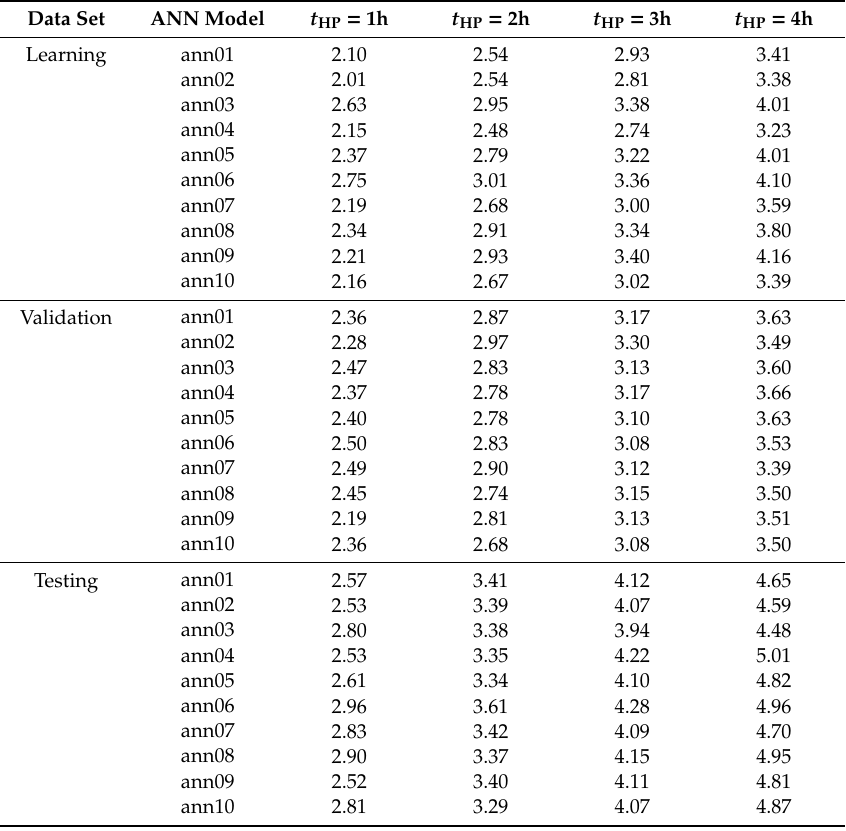
Table 2. RMSE values for different forecast time horizons.